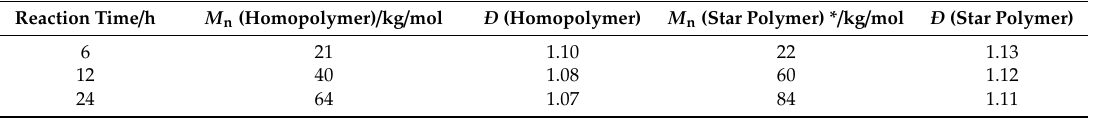
Table 1. Number average molar masses, M n , and dispersities, Ð , of the linear and four-arm star polystyrene (PS) as obtained via size-exclusion chromatography.